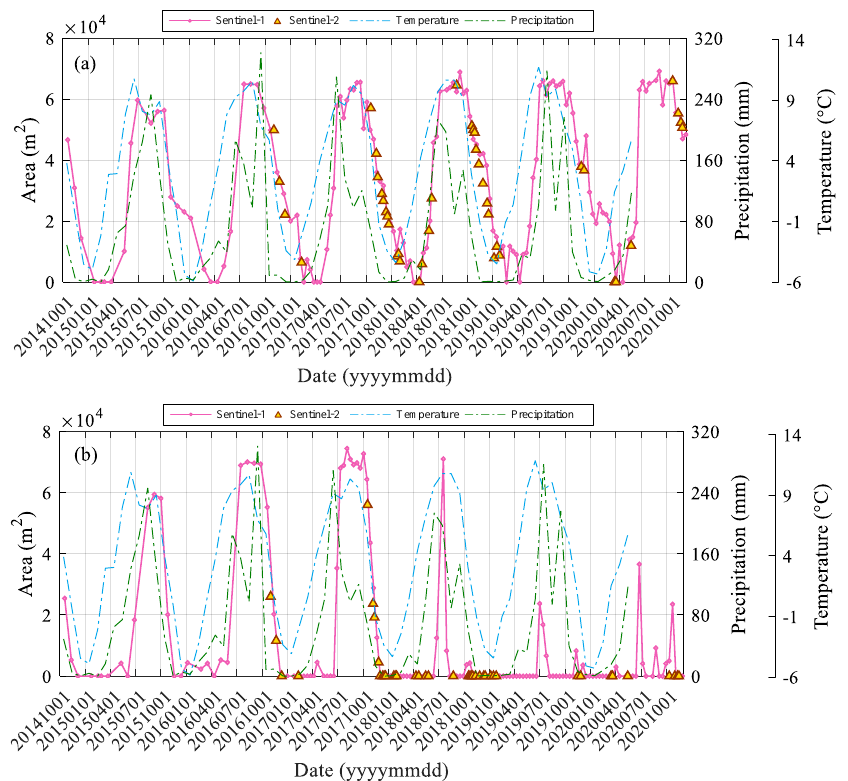
Figure 9. ( a , b ) show the XGL and DGL area changes from October 2014 to November 2020, respectively. The blue and green dotted lines represent the corrected monthly average temperature and monthly cumulative precipitation changes, recorded by Jiulong Station. The pink lines and the scattered triangles represent the spatiotemporal changes of glacial lakes calculated based on the Sentinel-1 SAR images and the Sentinel-2A/B optical images. The melting of snow and ice on the Gongba Glacier began in March every year with the temperature rising above 0 °C. Since May, the temperature continued warming and was accompanied by enhanced precipitation. The glacier entered a strong ablation phase, part of the meltwater flowed into the downstream river through the subglacial drainage system and some flowed into XGL and DGL through runoff from the debris-covered